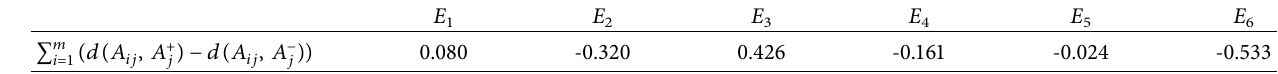
Table 10: The total distance of each criterion.